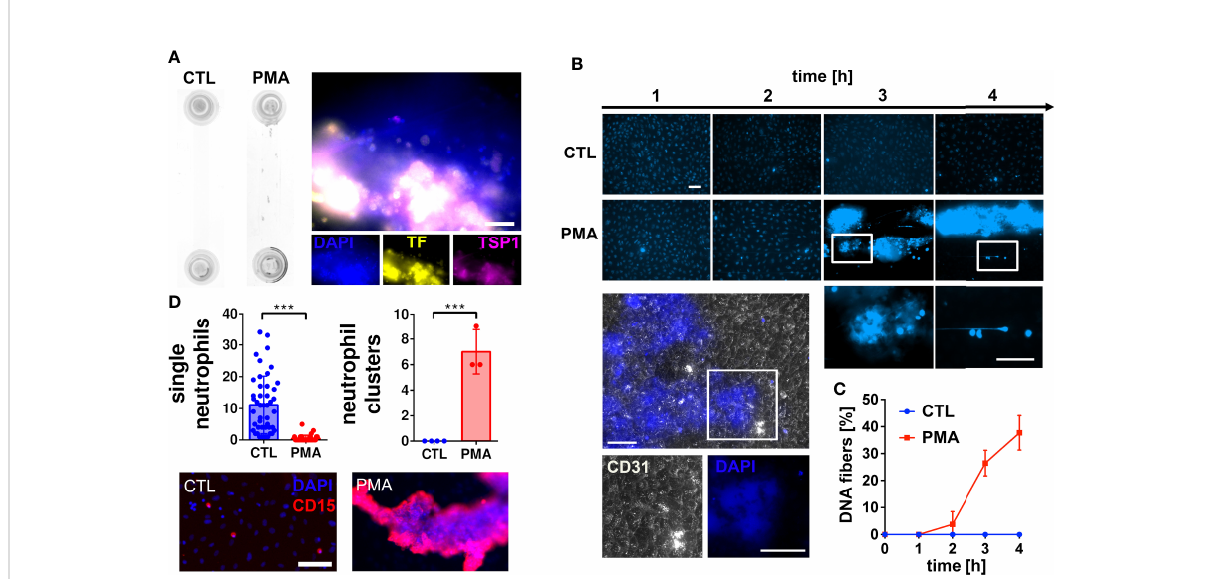
FIGURE 1 Neutrophil extracellular trap (NET) formation in hirudinated whole blood. (A) HUVECs were seeded into micro fl uidic channels and perfused with hirudinated blood at a shear stress of 0.5 Pa for 4 h. NETosis was induced by 15 nM PMA. Macroscopic blood aggregations were formed in PMA-treated slides but not in corresponding controls (CTL). Representative immuno fl uorescence staining of PMA treated slides indicates that aggregates contain DNA (DAPI), tissue factor (TF) and thrombospondin-1 (TSP1). Scale bar = 50 µm (B) Representative fl uorescence microscopy images of DAPI stained slides during the experiment. CD31 staining (white) shows that the endothelium underneath the DNA-rich aggregates remained intact. Nuclei of endothelial cells are not visible because the brightness and contrast settings of the images were adjusted to the strong fl uorescence signal emitted by the DNA aggregates. White boxes indicate magni fi ed areas. Scale bar = 50 µm. (C) Quantitative analysis of the time series experiment shows that the number of DNA fi bers increased time-dependently. (D) Fluorescence microscopic images of neutrophils after the fl ow experiment. Quanti fi cations of images are presented in bar diagrams indicating the number of single neutrophils and neutrophil clusters in control slides in comparison to PMA-treated slides. Scatter plots indicate the number of analyzed fi elds of view of three independent experiments (single neutrophils) or the number of neutrophil clusters per slide of three independent experiments (neutrophil clusters). Representative fl uorescence images of single neutrophils and neutrophil clusters are shown. CD15 was used as neutrophil surface marker (red). Scale bar = 100 µm. ***P<0.001, Student ’ s t